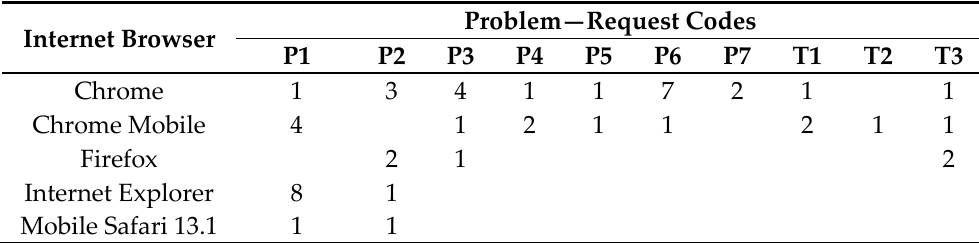
Table 4. Distribution of support request codes by internet browser.